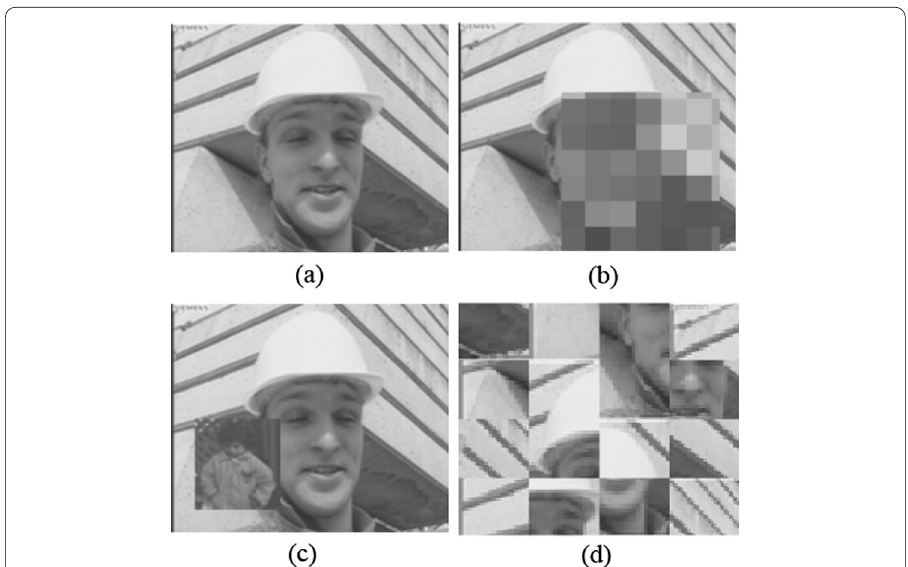
Fig. 4 Example of attacks of content distortion manipulations. a is original frame, b is block overlaying, c is pasted and d is reshuffled. Here shown are the examples of attacks on the frames. The upper left panel is the original frame; the upper right panel is the result of block overlaying attack. The lower left panel is the result of being pasted and the lower right panel is the result of reshuffling